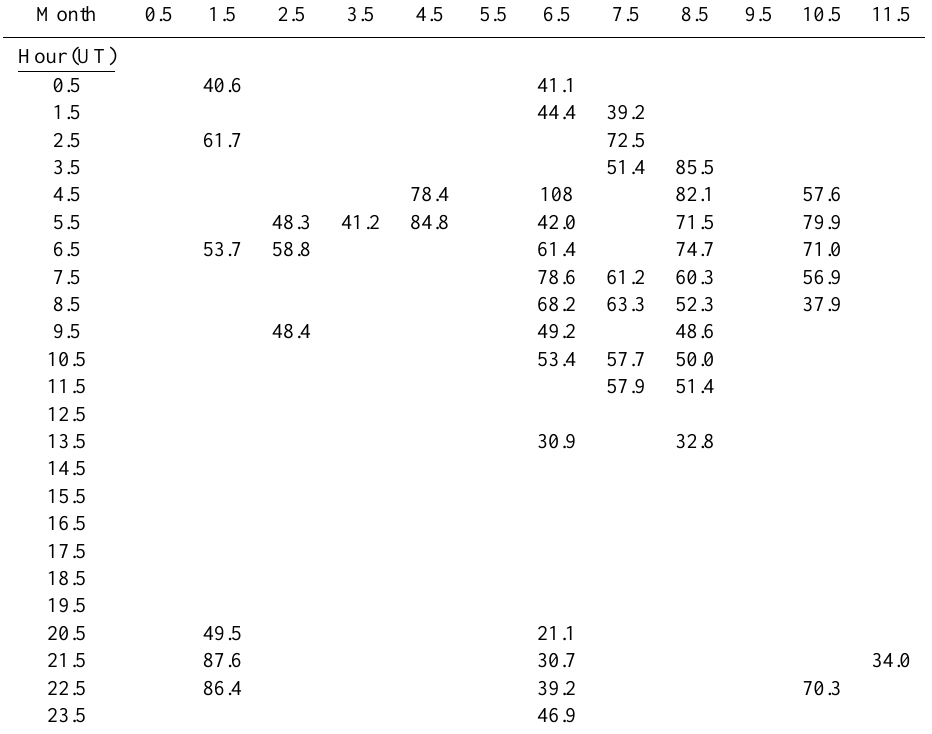
Table A3. Median Electron density at 90km for 1dB absorption